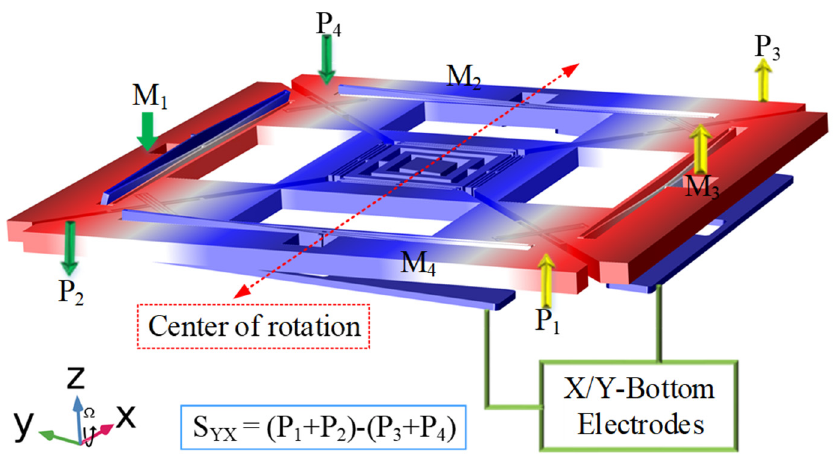
Figure 4. Cross-axis Displacement Measurement of the Designed MEMS Gyroscope.